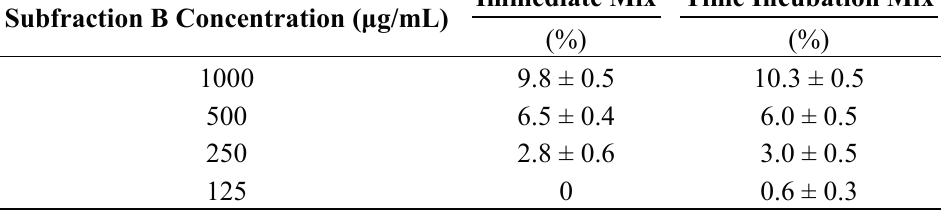
Table 1. Rosner Indexes for APTT 1:1 mixing studies of different concentrations of Subfraction B on standard human normal pooled plasmas. Subfraction B as active anticoagulant fraction was purified through a series of bioassay-guided fractionation. Values are mean ± S.E.M. ( n = 3).